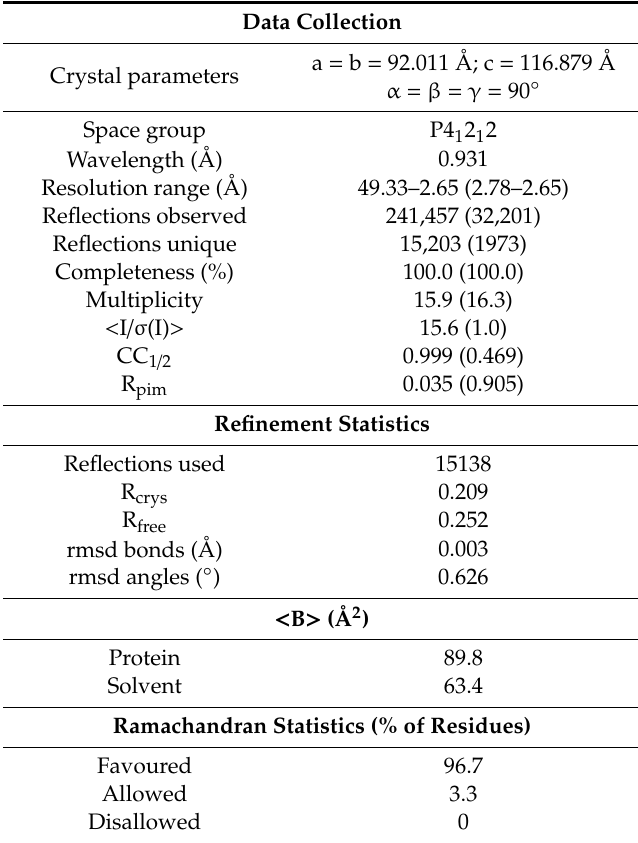
Table 1. Crystallographic data collection and refinement